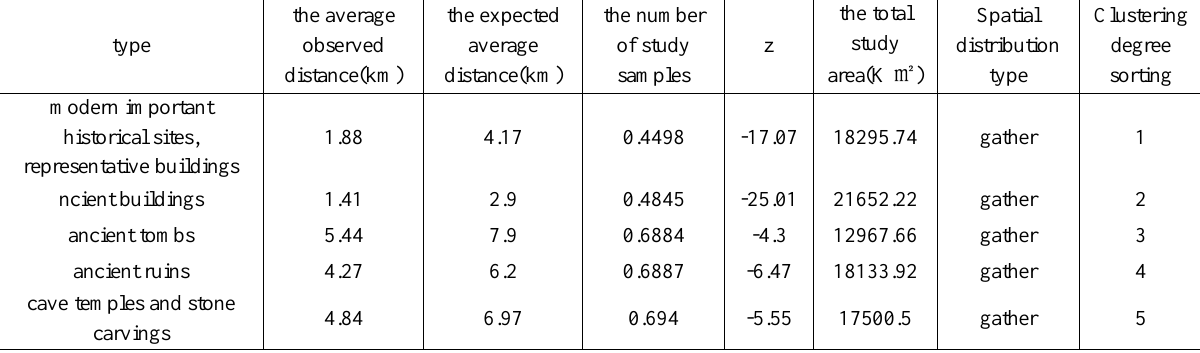
Table 1. Nearest Neighbor Index for Beijing's Cultural Heritage